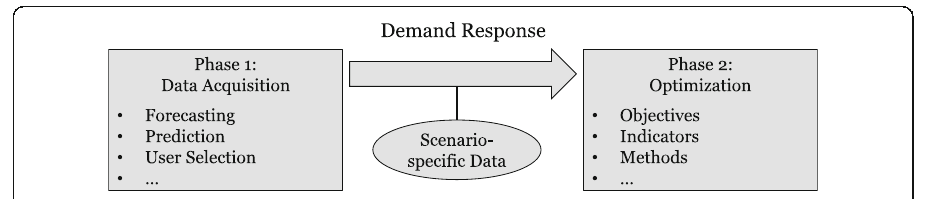
Fig. 3 DR phases, data sources, and scenario